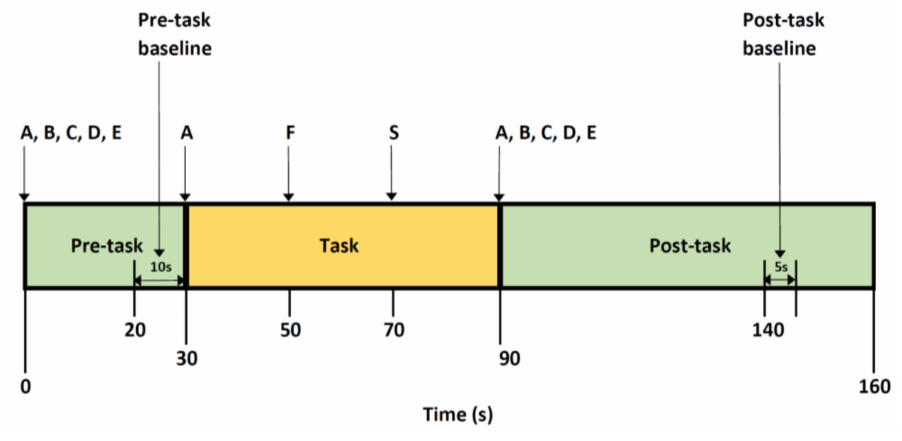
Figure 1. Verbal fluency test